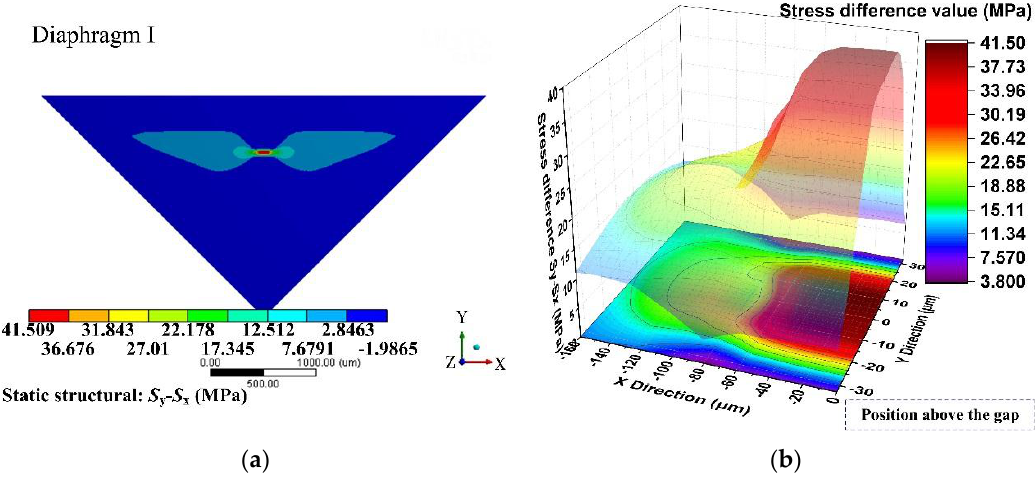
Figure 14. Stress difference ( σ = S y − S x ) distribution of diaphragm I: ( a ) stress difference ( σ = S y − S x ) distribution of a 1/4 model; ( b ) detailed stress difference ( σ = S y − S x ) distribution of 1/2 SCR.